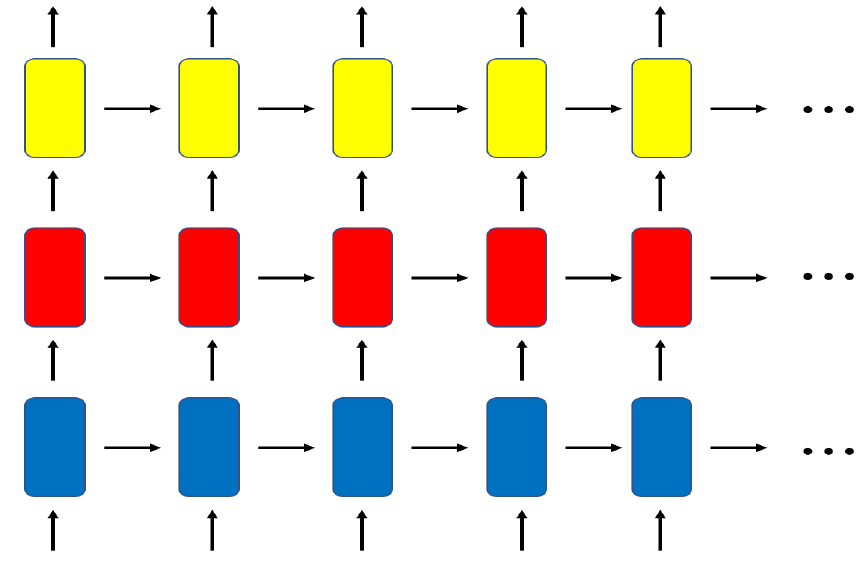
Figure 2. Structure of stacked recurrent neural